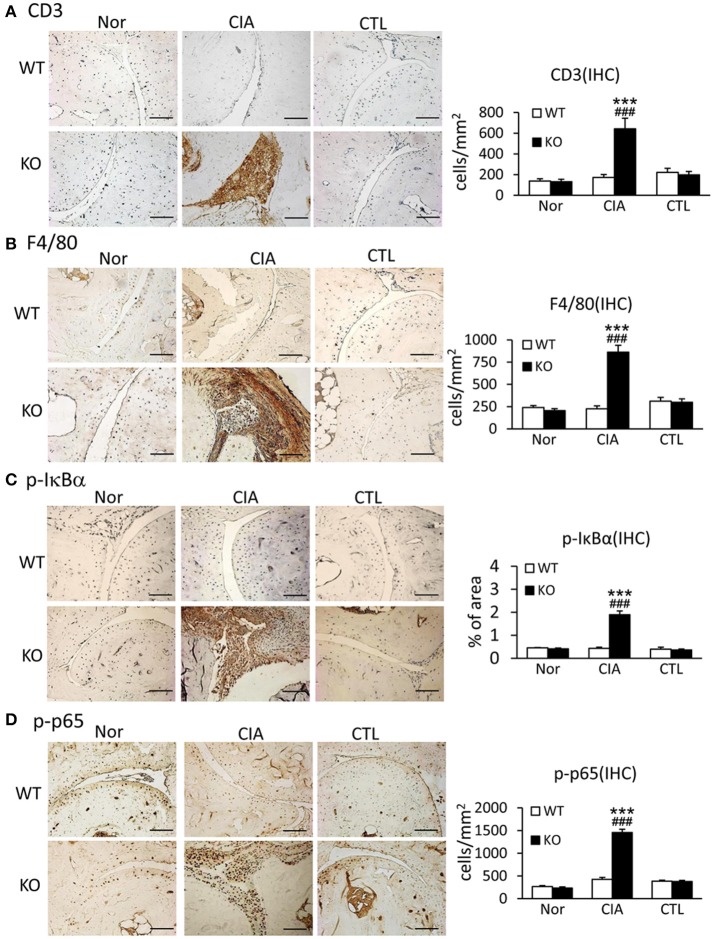
Deletion of Smad7 largely enhances synovial inflammation and activation of NF-κB signaling in CIA mice. (A) CD3 expression. (B) F4/80 expression. (C) Phospho-IκBα. (D) Phospho-p65. Results show that severe joint inflammation evidenced by many CD3+ T cells and F4/80+ macrophages and a marked activation of NF-κB signaling developed in Smad7-KO but not in Smad7-WT CIA mice (CD-1 background). Data are expressed as mean ± S.E. for group of 8 mice. ***p < 0.001 vs. control (CTL); ###p < 0.001 vs. WT-CIA group. Scale bar, 50 μm.